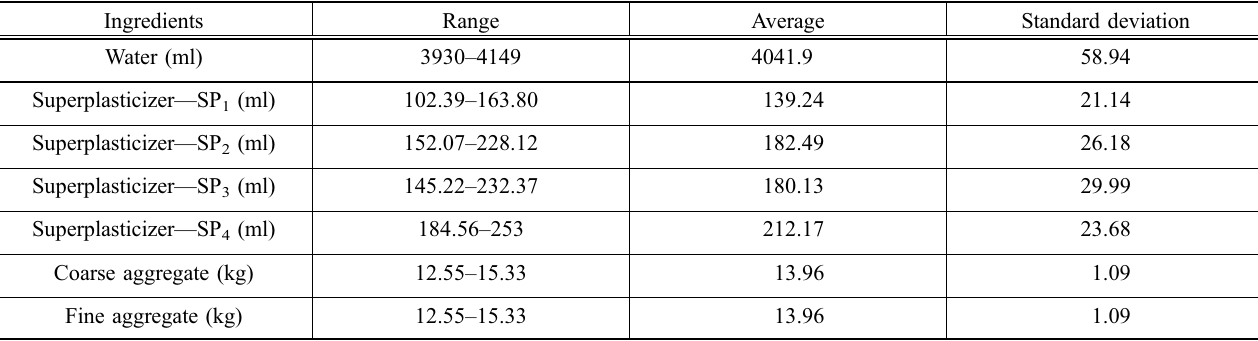
Table 3 Ranges of ingredients of the SCC